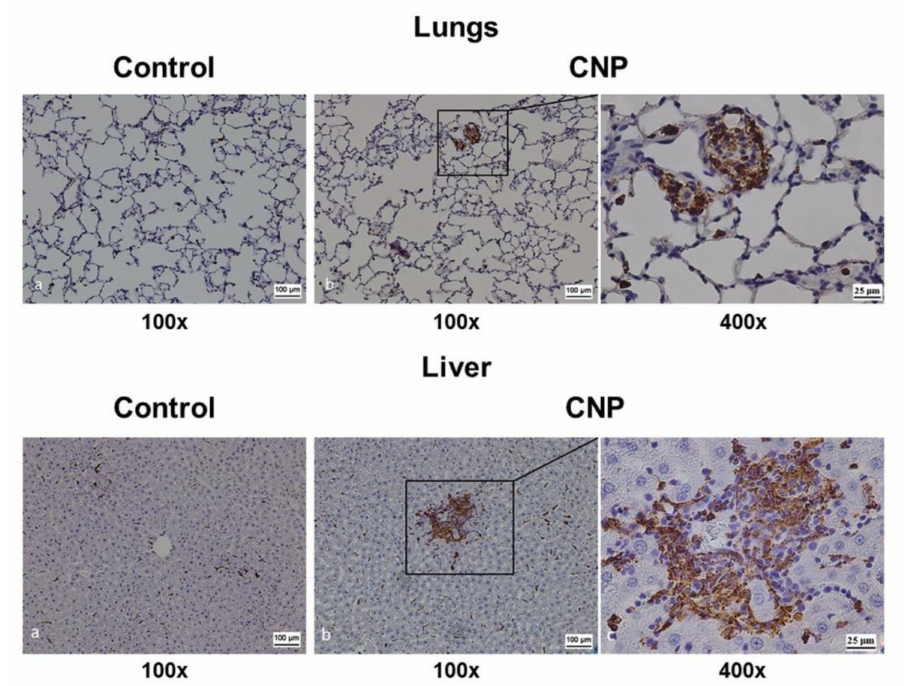
Figure 13. Thelungsandliverofratsat14daysafterCNPadministration4mg / kg. Immunohistochemistry analysis with antibodies to CD68 + . Areas with CD68 + -macrophage